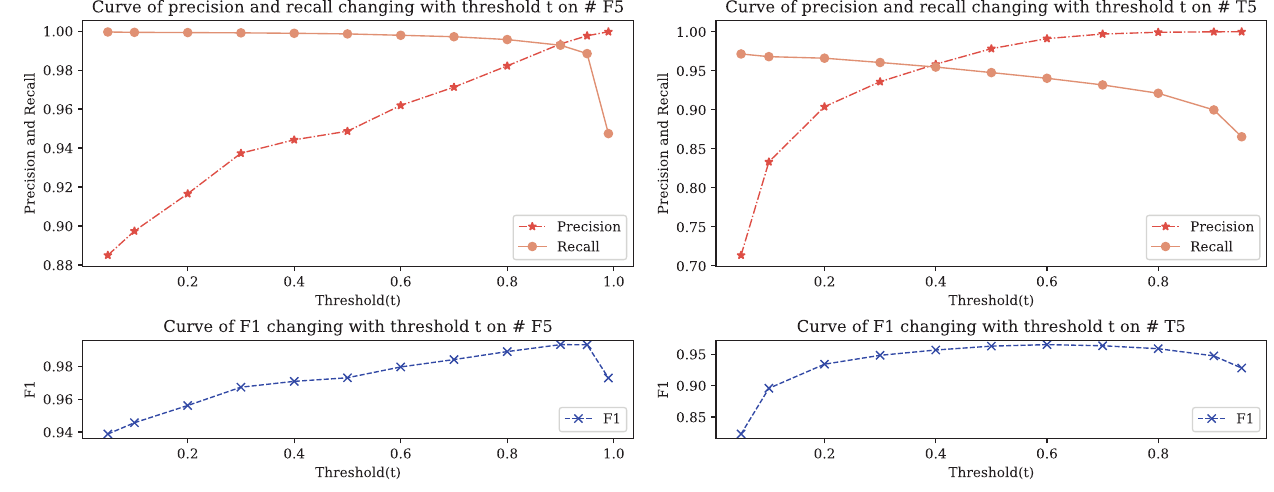
Figure 3. Curve of precision , recall and F 1 of the CFR changing with threshold ( t